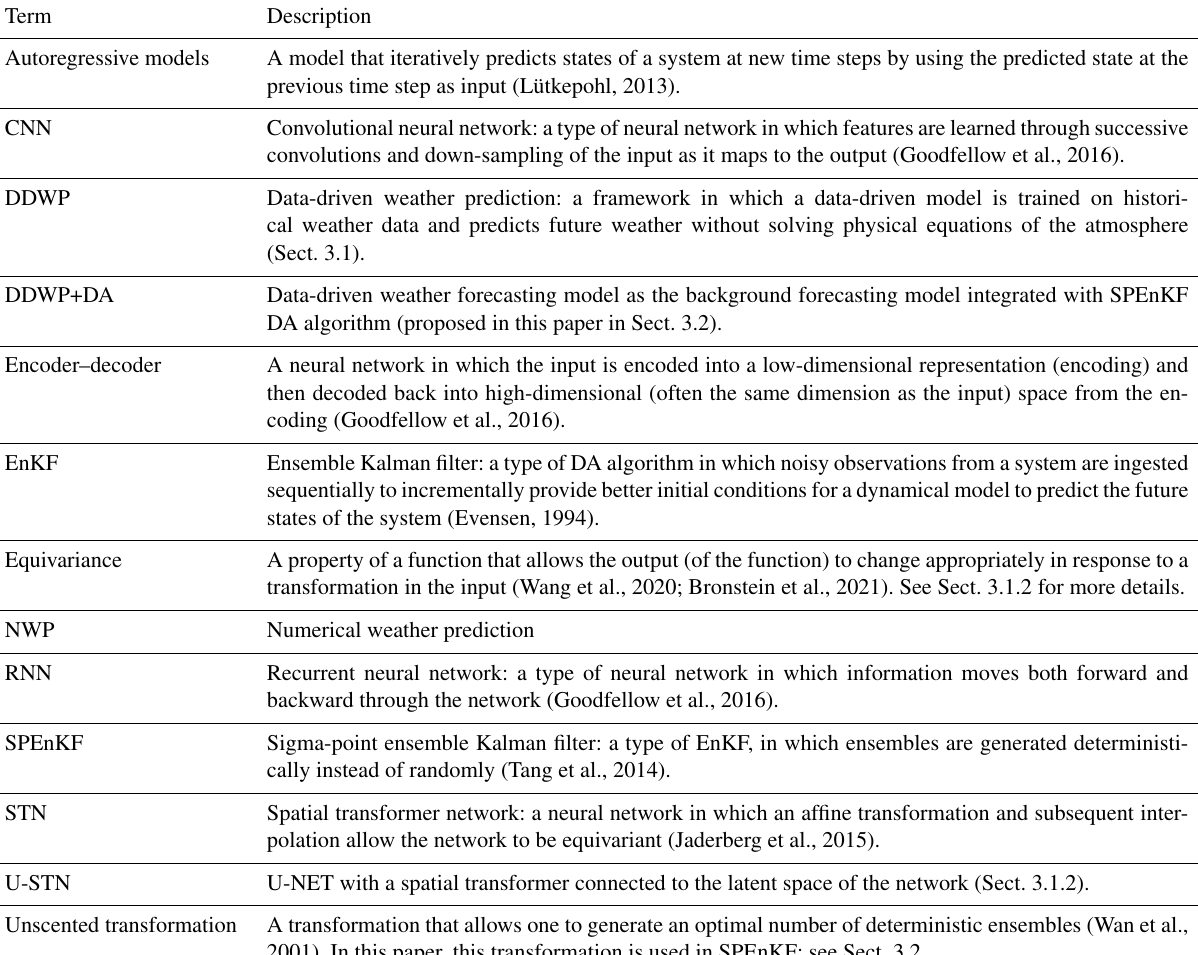
Table 1. List of acronyms and technical ML and DA terms along with their brief descriptions. Term Description Autoregressive